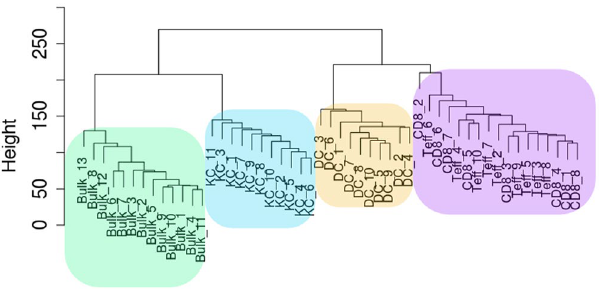
Figure 2. Unsupervised hierarchical clustering reveals that the keratinocyte populations are most similar to bulk samples. Dendrogram from unsupervised hierarchical clustering of each cell population and the bulk